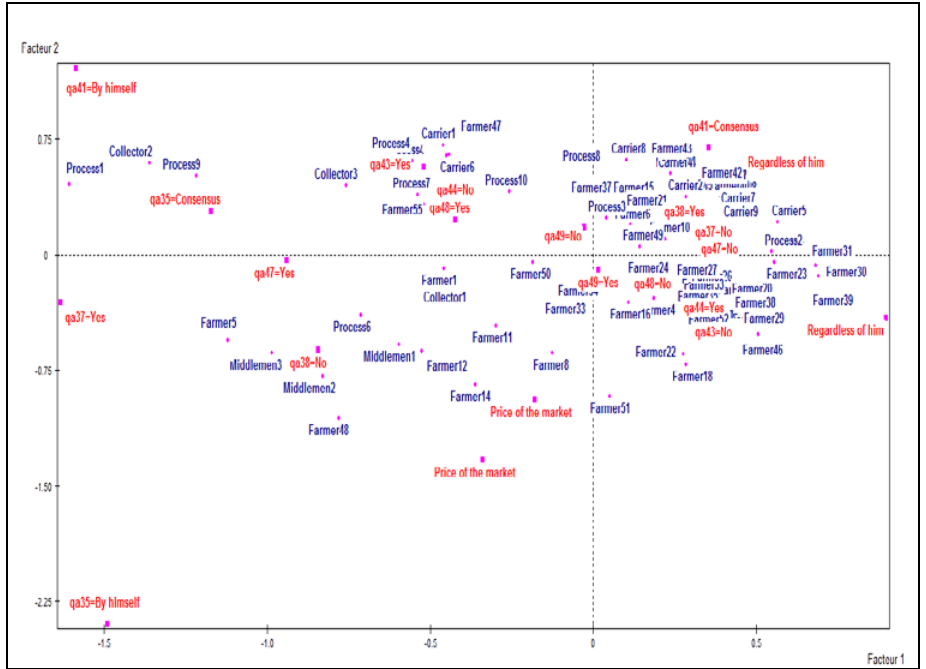
Figure 6. Influence levels of the different nodes of the peanut value